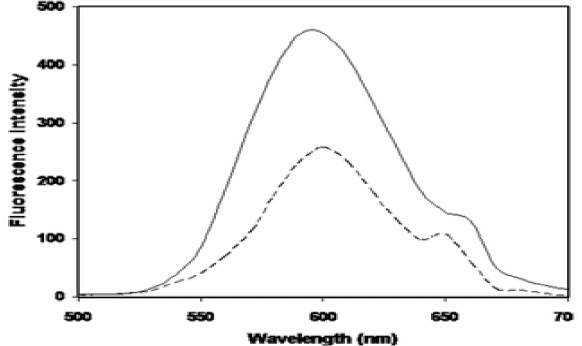
Figure 1. Fluorescence emission spectra of native human DNA (——) and modified human DNA with 1.515 mM N-OH-AABP (–). The fluorescence scan was performed in triplicate. The plot was created by taking the average of three scans. The modification was statistically significant as compared to the control ( p < 0.005). Reprinted with permission from Ref. [12]. Copyright 2013 PLoS